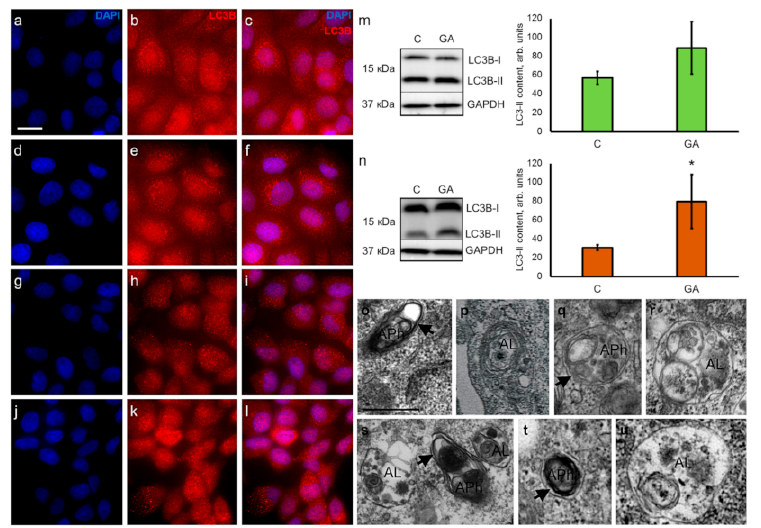
Figure 3. Immunocytochemical visualization of autophagy marker LC3B and analysis of LC3B-II content in keratinocytes HaCaT and carcinoma A431 cells. ( a – f ) Keratinocytes HaCaT in control specimens ( a – c ) and in the presence of GA ( d – f ); ( g – l ) carcinoma A431 cells in control specimens ( g – i ) and in the presence of GA ( j – l ). Nuclei are stained with DAPI (left column), autophagosomes are visualized with anti-LC3B antibodies (middle column), merged images (right column). Scale bar, 20 µ m. Western blot analysis and evaluation of LC3B-II content in HaCaT ( m ) and A431 ( n ) cells. C— cells growing with ethanol as a solvent for GA (control for GA). Data are shown as mean ± standard deviation ( n = 3); * p ≤ 0.05 according to the Mann–Whitney test. TEM images of autophagosomes (APh) and late autolysosomes (AL) in HaCaT ( o – r ) and A431 cells ( s – u ). Autophagosomes and autolysosomes are present in control specimens of HaCaT ( o , p ) and A431 cells ( s ), and in GA-treated HaCaT ( q , r ) and A431 cells ( t , u ). Arrowheads point to the gap between two membranes surrounding autophagosomes. Scale bar, 0.5 µ